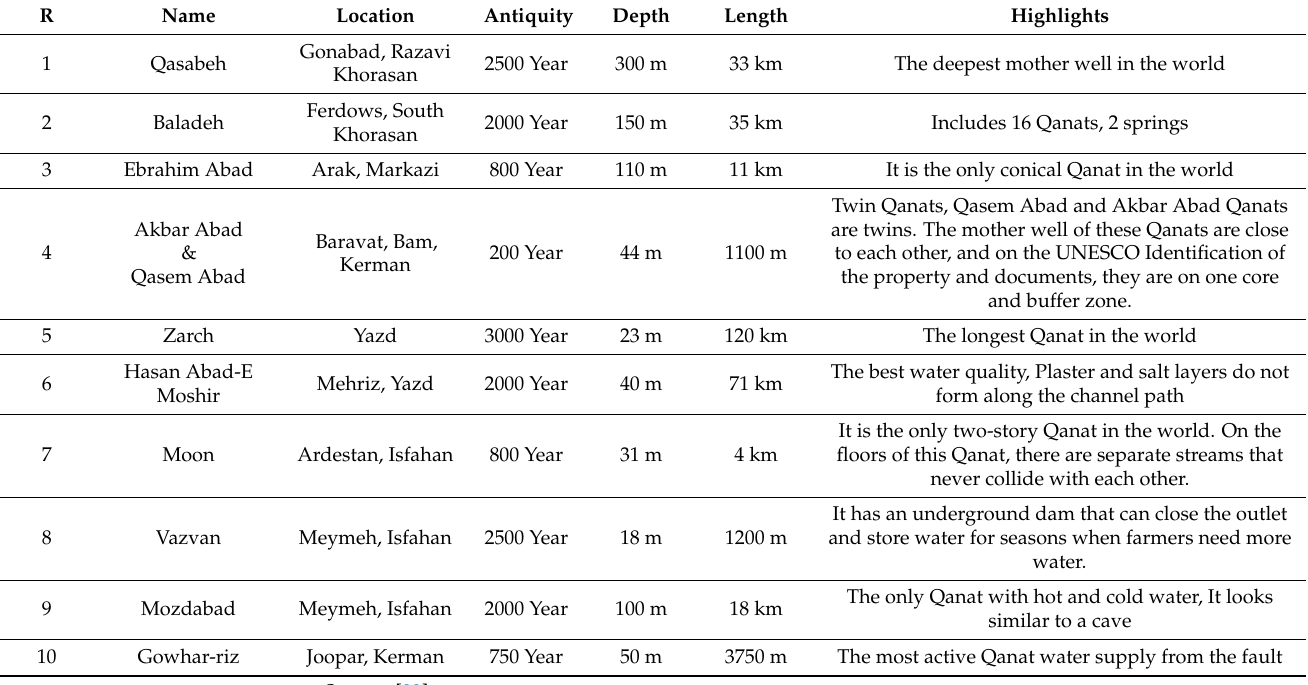
Table 1. PQs listed as UNESCO World Heritage